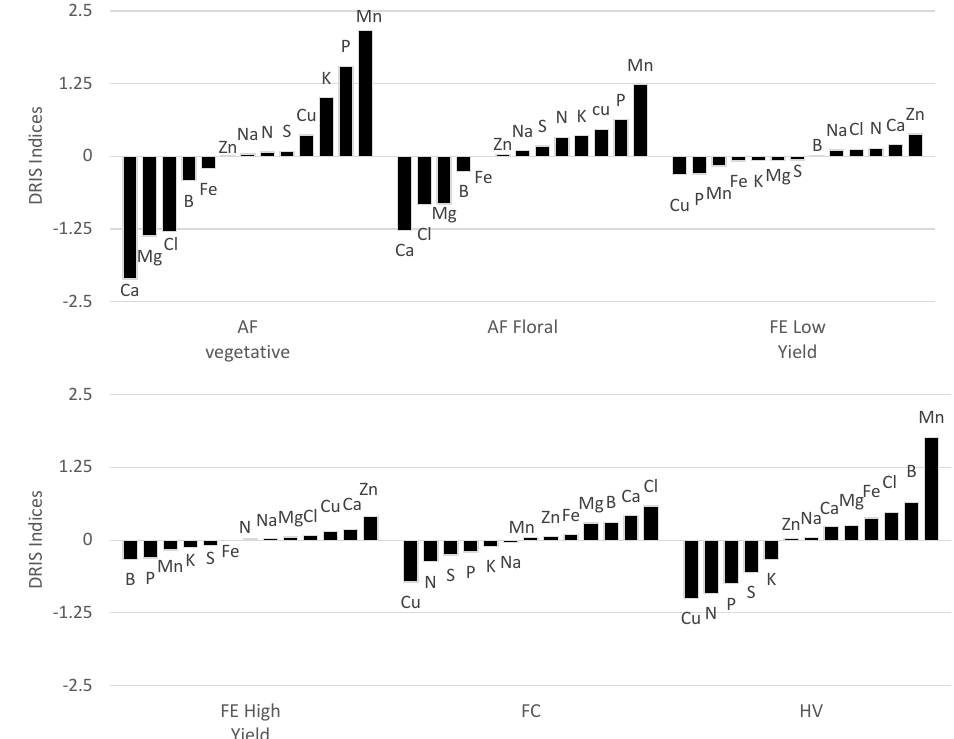
Figure 5. Limiting order of nutrients of the total population in each phenological stage (AF; FE; FC; HV) according to the DRIS indices determined using the whole database (high- and low-yielding populations) of ‘Rojo Brillante’ persimmon PDO ‘Kaki Ribera del Xúquer’, Spain.